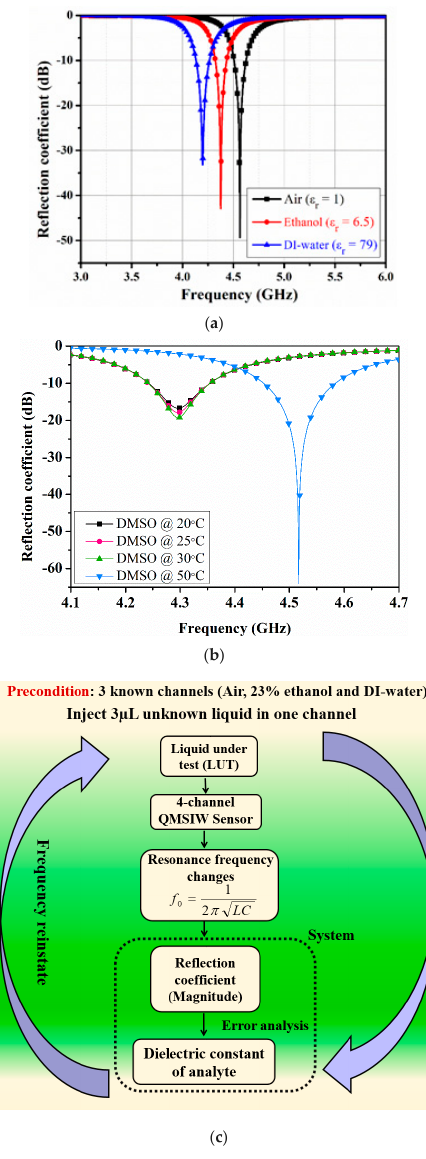
Figure 5. ( a ) Simulated reflection coefficients for the proposed 4 ‐ port quarter ‐ mode substrate ‐ integrated waveguide resonator. Dielectric properties were considered at room temperature (20 °C), ( b ) Simulated reflection coefficient of port 1 (S 11 ) when the first microfluidic channel is filled with the dimethyl sulfoxide (DMSO) for a range of temperatures. The remaining three ports are kept open. ( c ) Proposed simplified